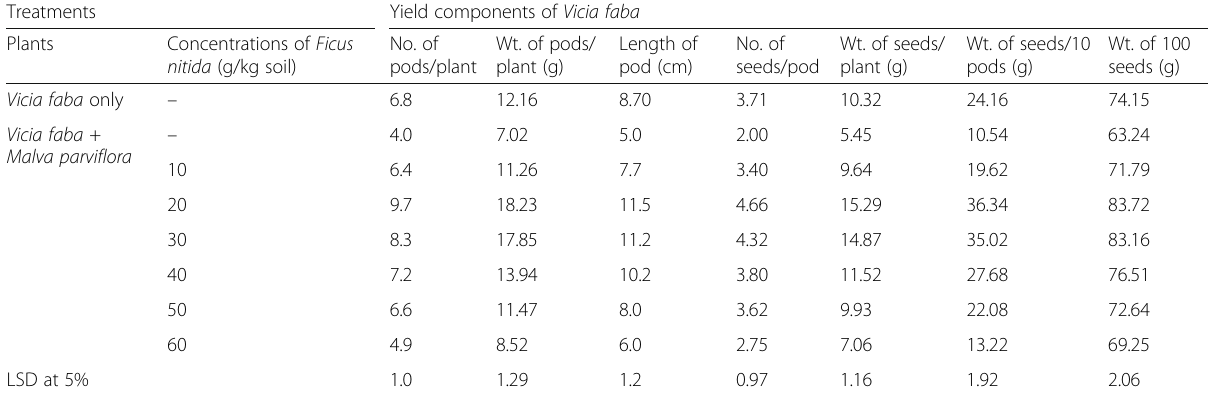
Table 6 Effect of Ficus nitida leaf powder on yield components of Vicia faba plants associated with Malva parviflora at harvest (average of the two seasons) Treatments Yield components of Vicia faba Plants Concentrations of Ficus No. of Wt. of pods/ nitida (g/kg soil) pods/plant plant